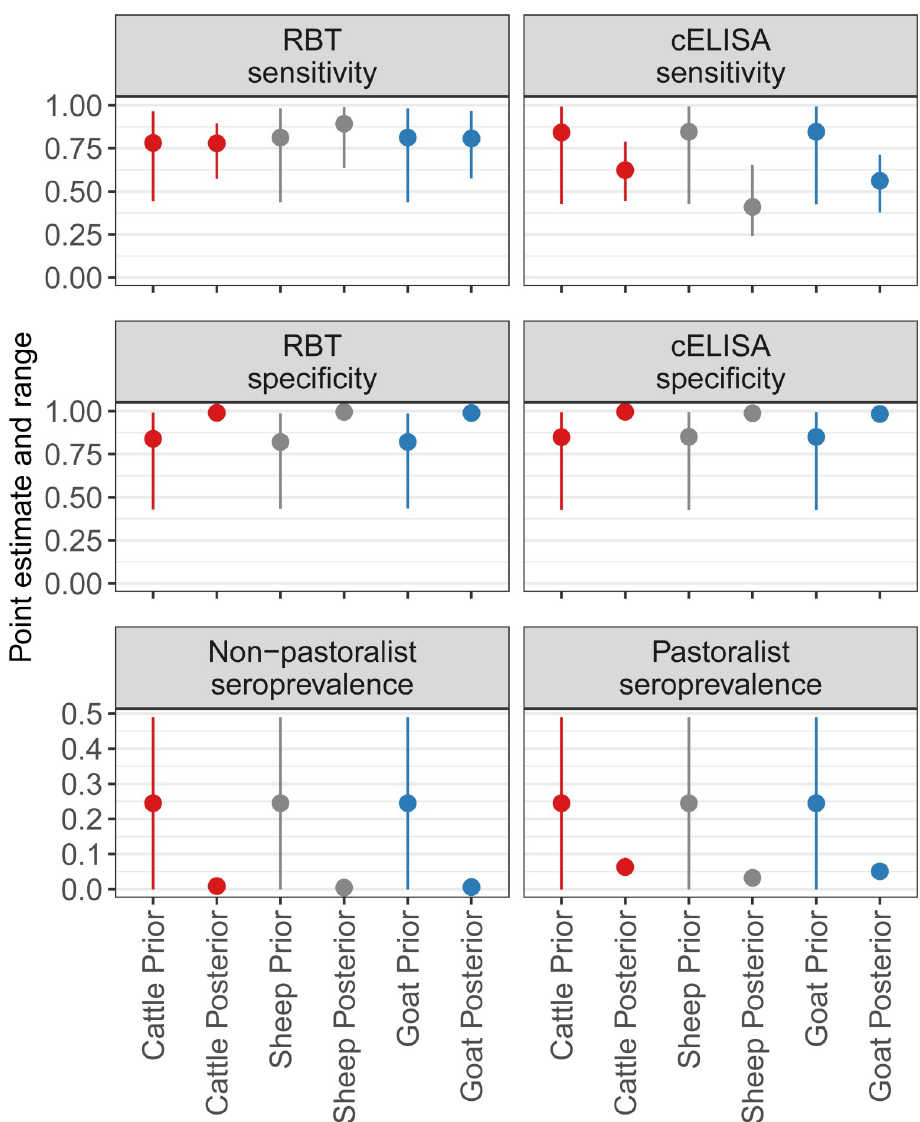
Fig 2. Sensitivity, specificity and seroprevalence prior and posterior point estimates and ranges for species models. Cattle, sheep, and goat data are from the combined BacZoo study conducted 2013 to 2015 in Arusha and Kilimanjaro Regions, and the SEEDZ study conducted in 2016 in Arusha and Manyara Regions of Tanzania. Point estimate refers to beta distribution mode for priors, and the median estimate for posteriors. Range refers to the beta distribution range for priors, and 95% Bayesian credibility interval for posteriors. RBT is Rose Bengal plate test. For sheep and goat models, RBT refers to the modified RBT 3:1 serum to antigen ratio. cELISA is the Animal and Plant Health Agency, UK, competitive enzyme-linked immunosorbent